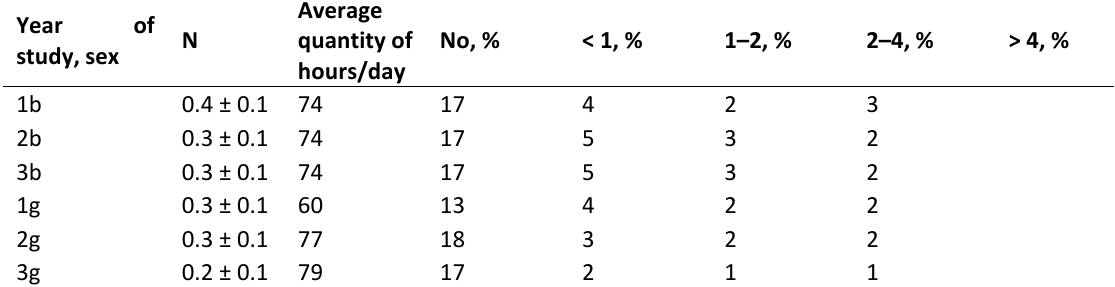
Table 3. Distribution of students by time (hours/day), spent for watching anime